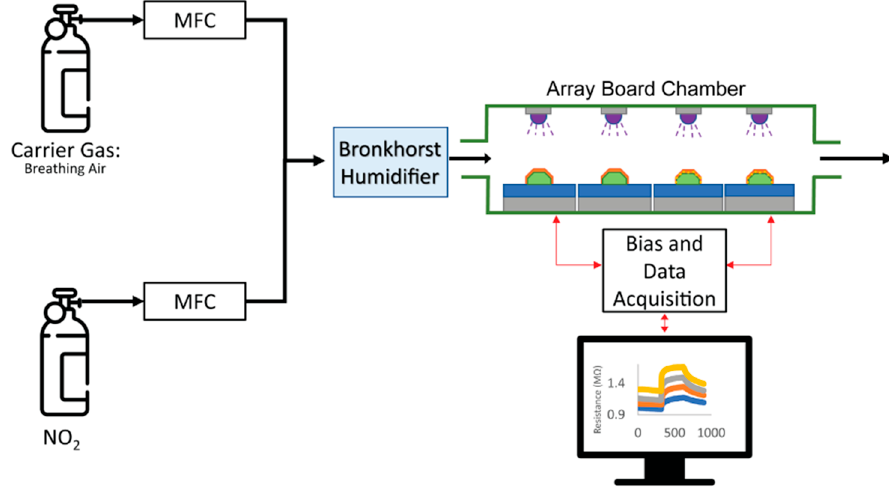
Figure 3. Experiment setup for sensor testing.